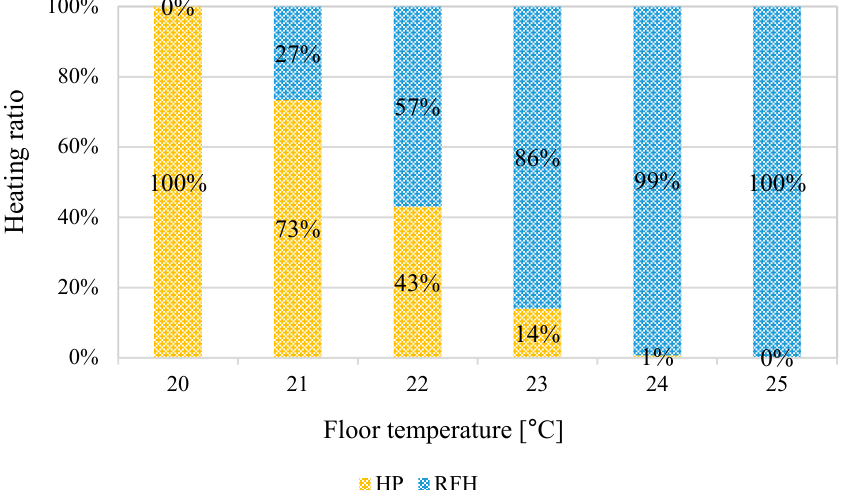
Figure 5. Heating charge ratio of the systems with variation in floor temperature. HP: convective air heating heat pump, RFH: radiant floor heating system.